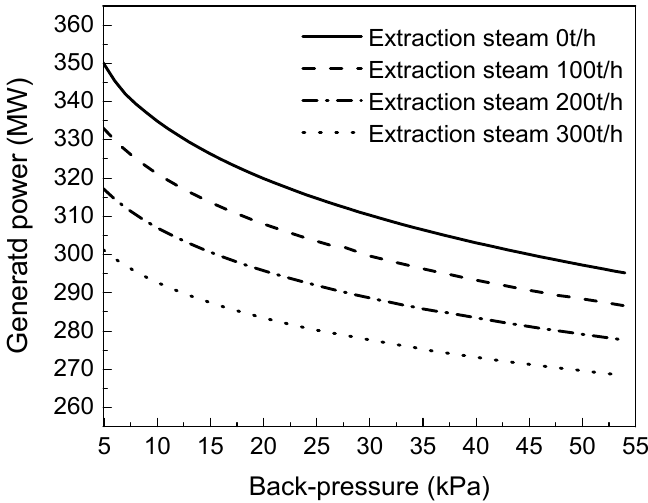
Figure 3. Variations in power of the combined heat and power (CHP) unit with increasing back pressure.